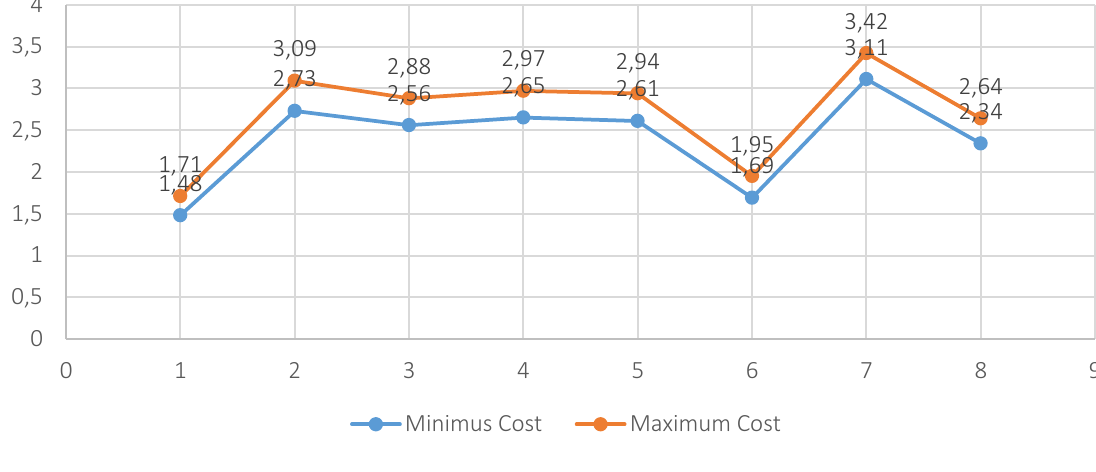
Figure 2. Estimated annual operating